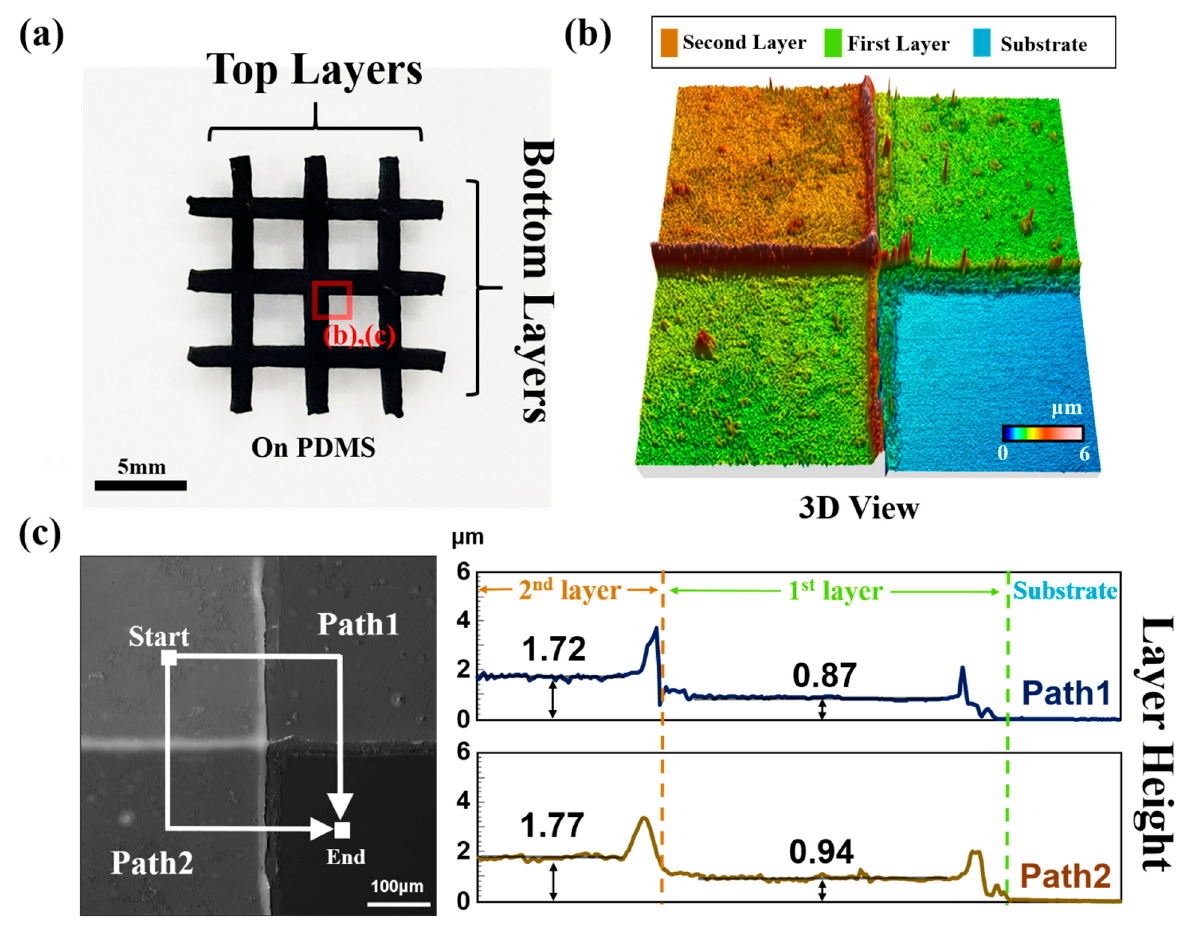
Figure 2. Three-dimensional (3D) analysis of a 3D SWCNTs pattern. ( a ) 3D SWCNT pattern on PDMS. ( b ) Optical surface profiler topographic image of a part of the pattern. ( c ) Vertical profile of a part of the pattern.